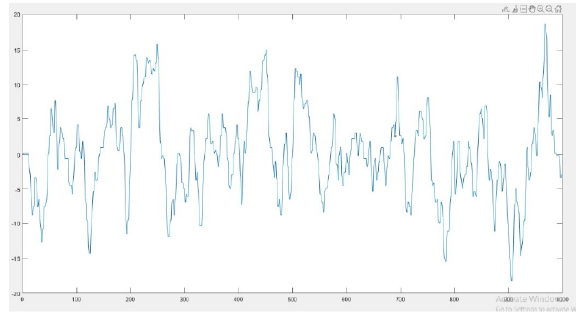
Figure 5. Median Filtered Output